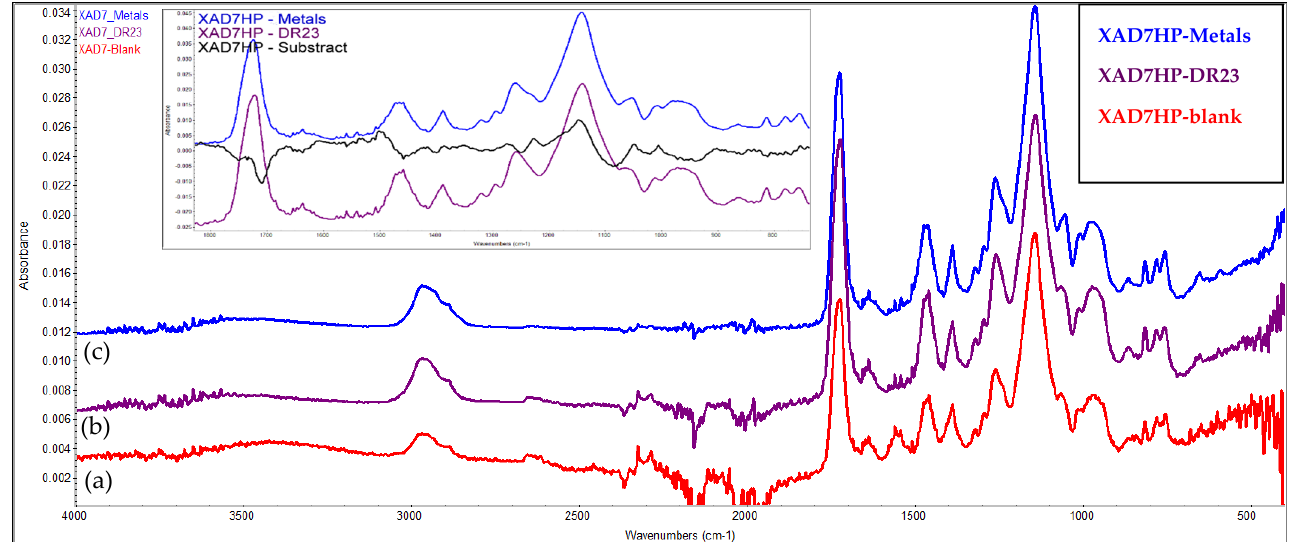
Figure 9. FTIR spectra of ( a ) XAD7HP, ( b ) XAD7HP-DR23 and ( c ) XAD7HP-DR23-M 2+ ; insert represents the subtraction of the FTIR spectra of XAD7HP-DR23 and XAD7HP-DR23-M 2+ .